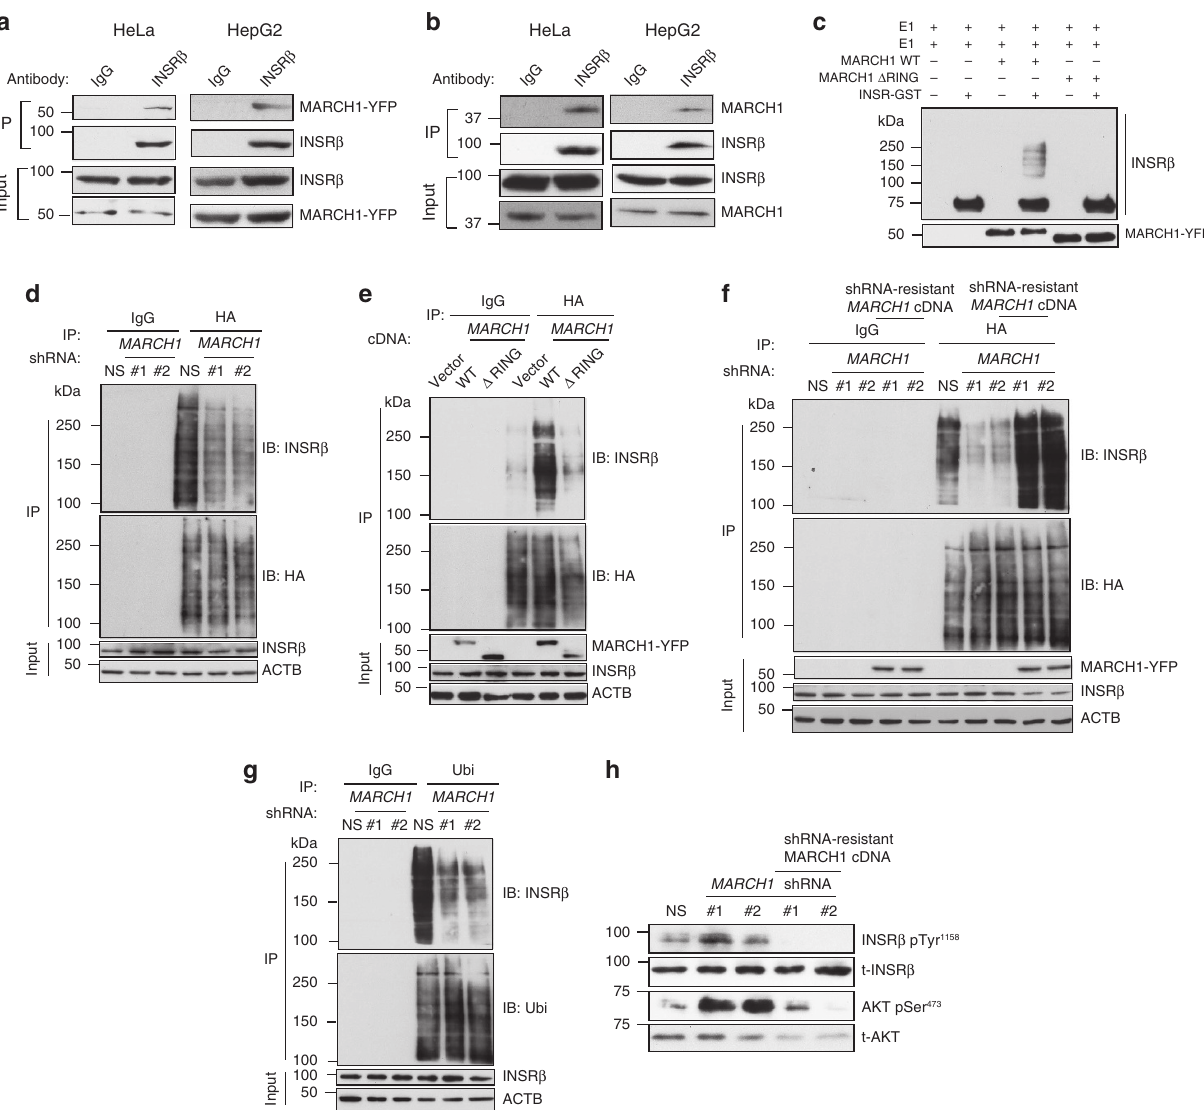
insulin-stimulated INSR and AKT phosphorylation, but this effect was reversed upon expression of shRNA-resistant MARCH1 cDNA (Fig. 8h).